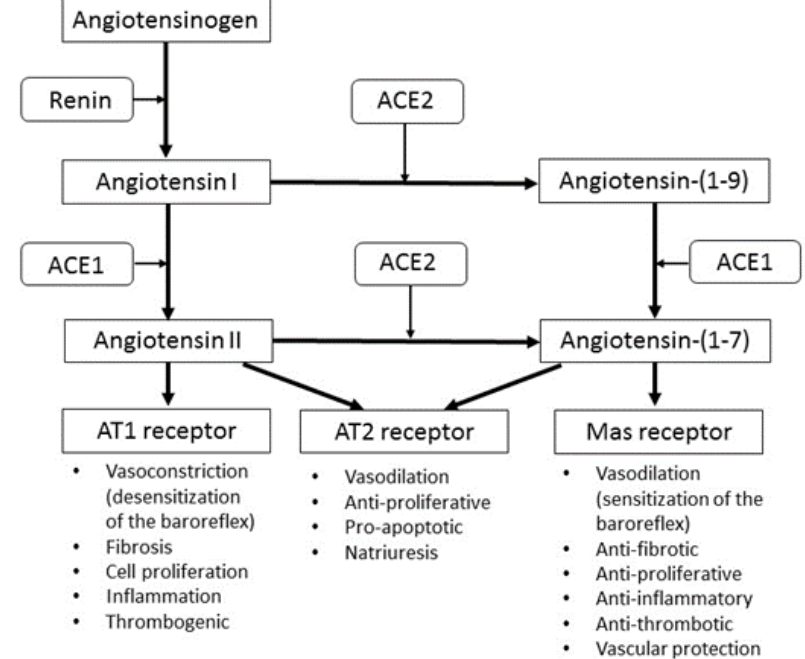
Figure 1. A current perspective of the ACE1 and ACE2 RAS pathways. ACE: angiotensin converting enzyme; AT: angiotensin.